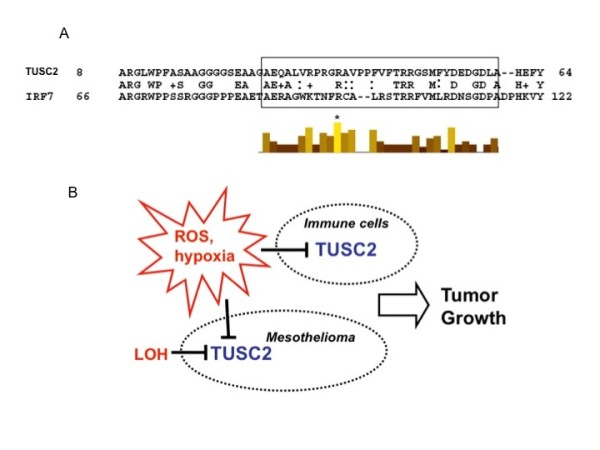
Molecular and biological properties of TUSC2. A. Similarity with the interferon regulatory factor IRF7 suggests DNA-binding property for TUSC2. N-terminus of TUSC2 shows ~40% identity with the IRF7 segment that contains a DNA-binding site (framed). Histogram shows positions conserved in the IRF protein family. The arginine residue (R) conserved throughout the IRF protein family is marked with asterisk. B. Different mechanisms of TUSC2 down-regulation in tumor and immune cells. Modulation of TUSC2 in tumor and host immune cellular compartments may contribute to tumor growth via blocking TUSC2 tumor suppressive or immune-regulatory properties.